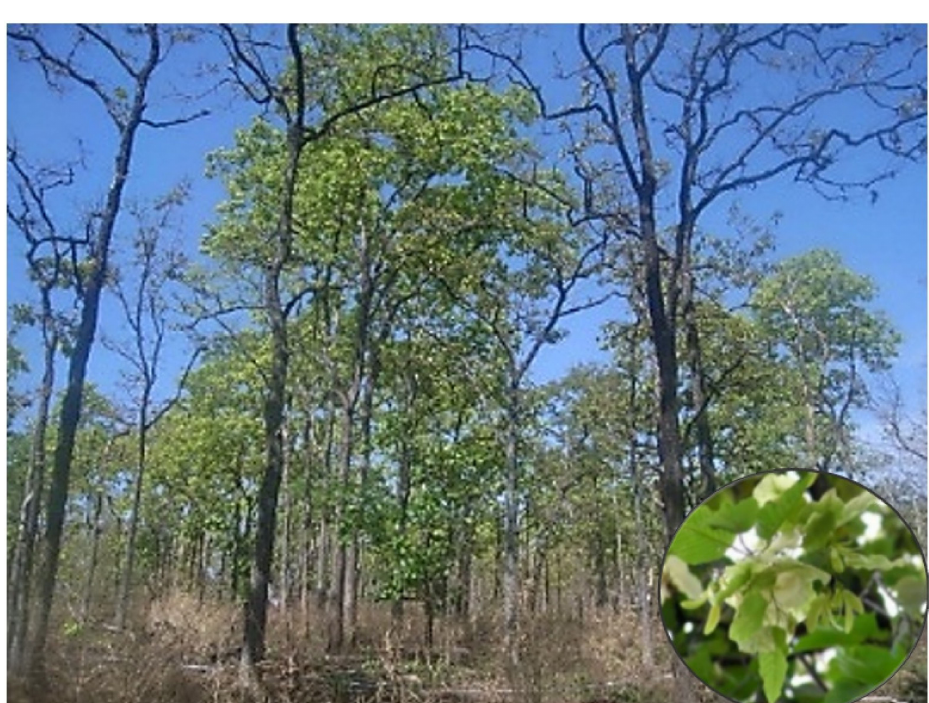
Figure A2. Shorea siamensis